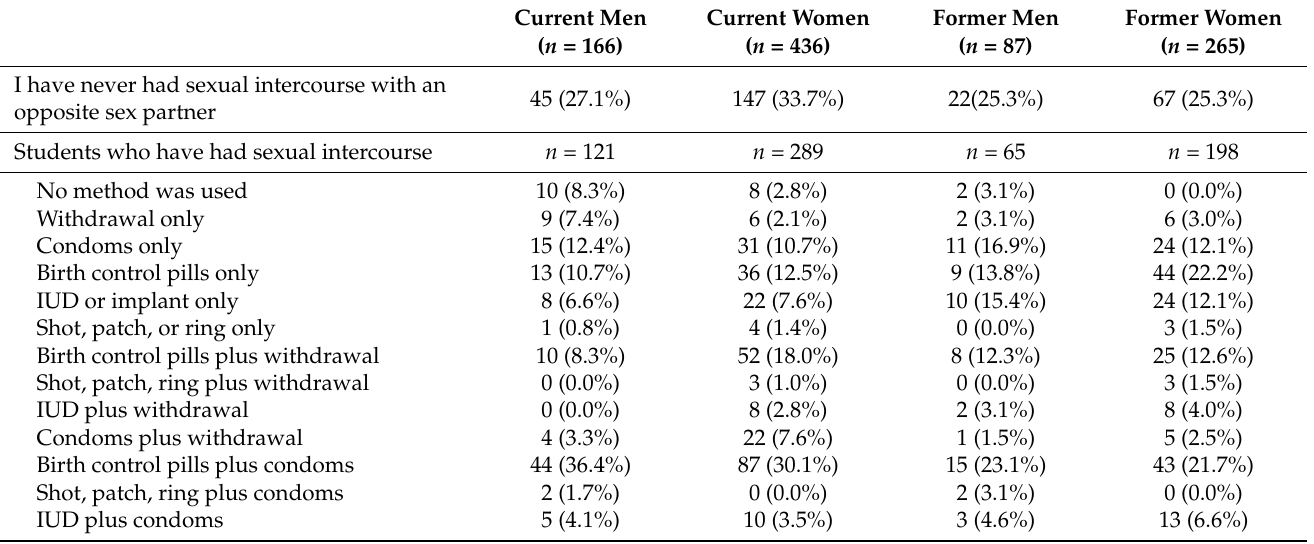
Table 1. Contraceptive methods used by unmarried current and former students in a U.S. university comprehensive sexuality course.